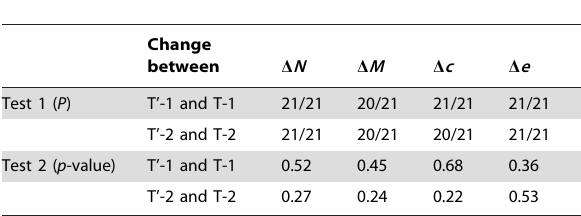
Table 2. Results of Test 1 and Test